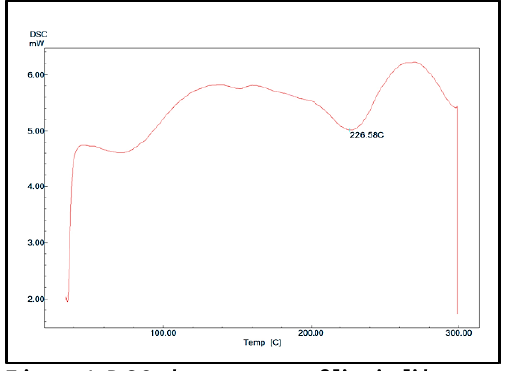
Figure 2. DSC thermogram of Avicel PH 102.